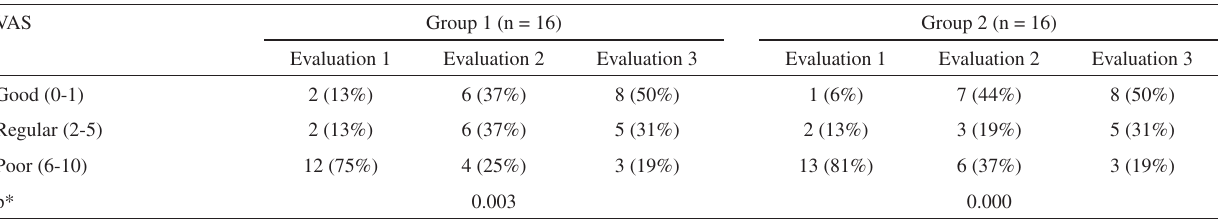
Table 5 – Patient distribution according to intensity of orthostatic pain on visual analog scale (VAS) in Groups 1 and 2 before and after treatment